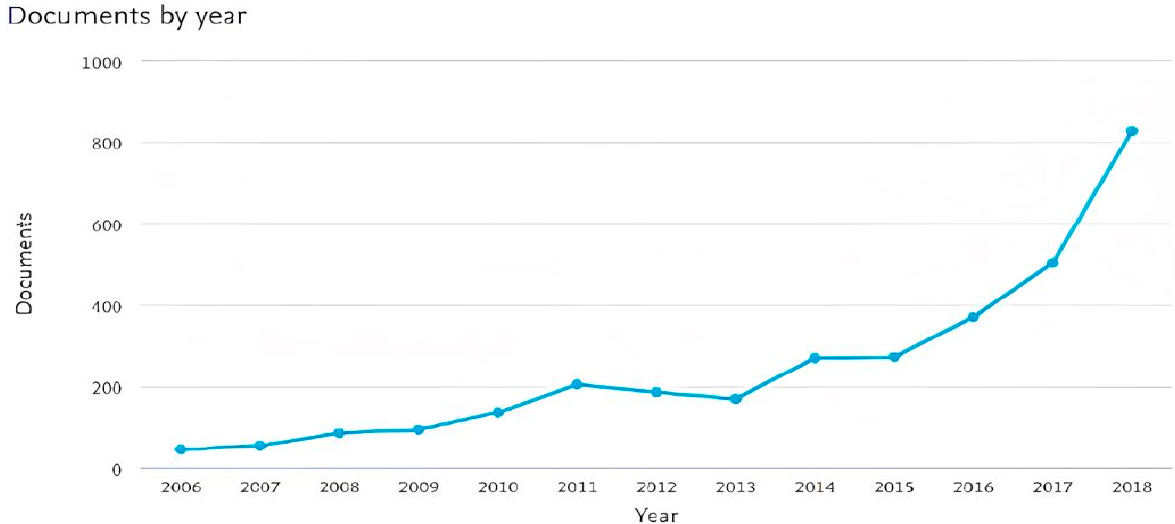
Figure 6. The progress of AI models usage in engine prediction over the last decade.